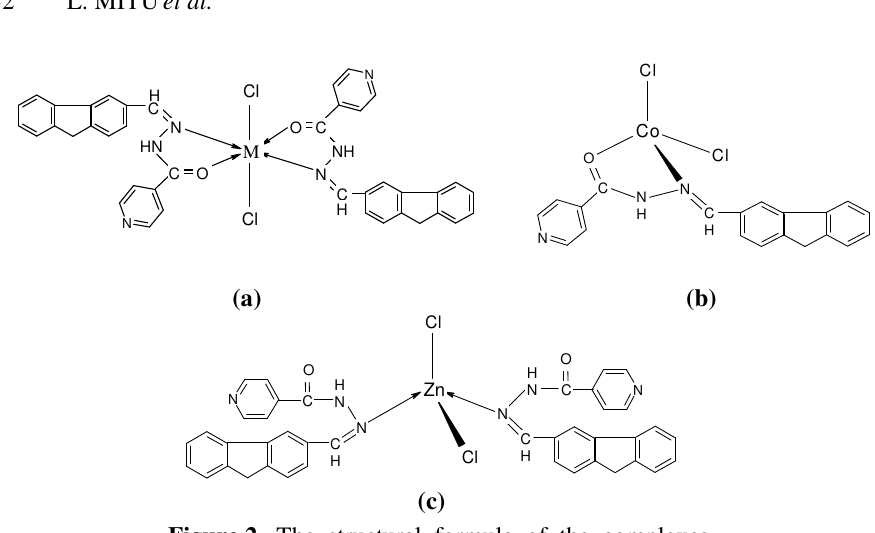
Figure 2. The structural formula of the complexes. ( a ) [M(INHAF) 2 Cl 2 ] M = Cu(II), Ni(II) ( b ) [Co(INHAF)Cl 2 ] ( c ) [Zn(INHAF) 2 Cl 2 ]